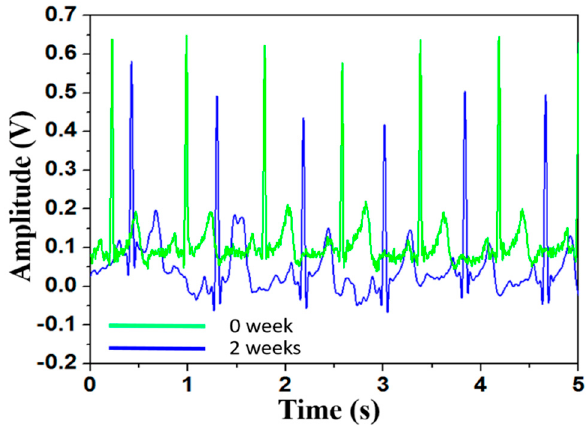
Figure 9. The stability test of the fabricated CG/f@MWCNTs-25% electrodes after two weeks in fingertips.